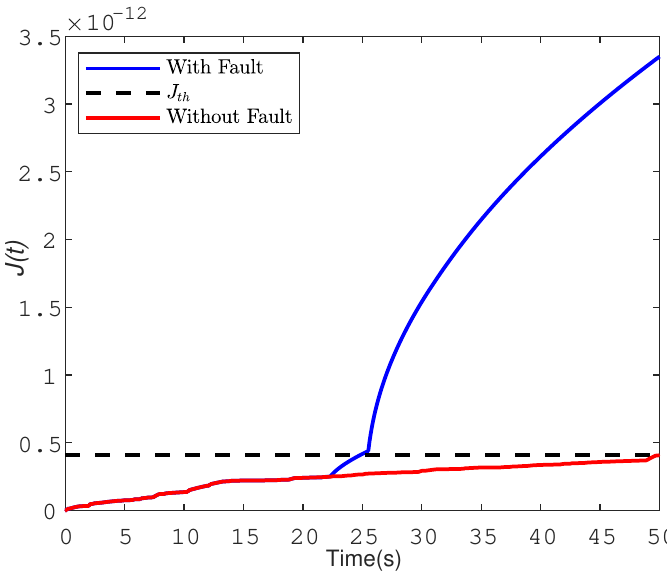
Figure 5. The trajectories of evaluation function with/without